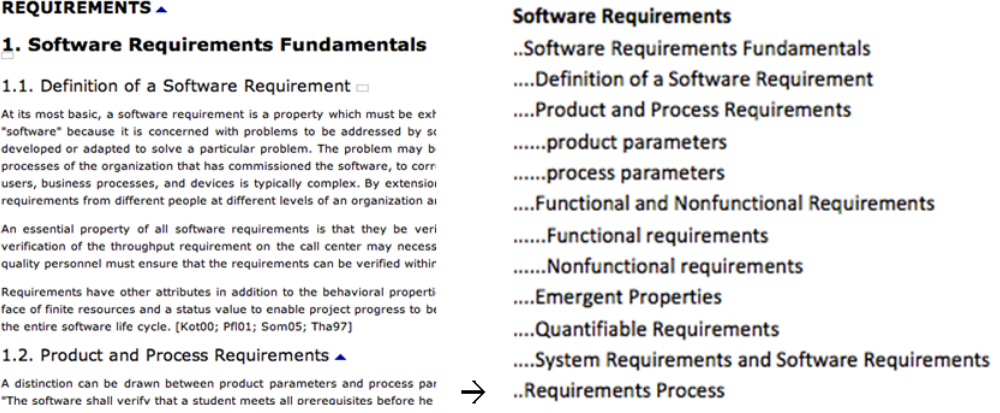
Figure 10. Extracted concept hierarchy (on the right) of SWEBOK source document (on the left)